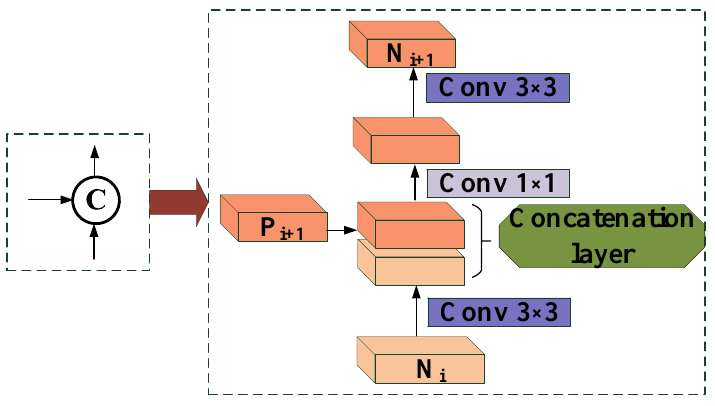
Figure 3. An illustration of our modification of the bottom-up path